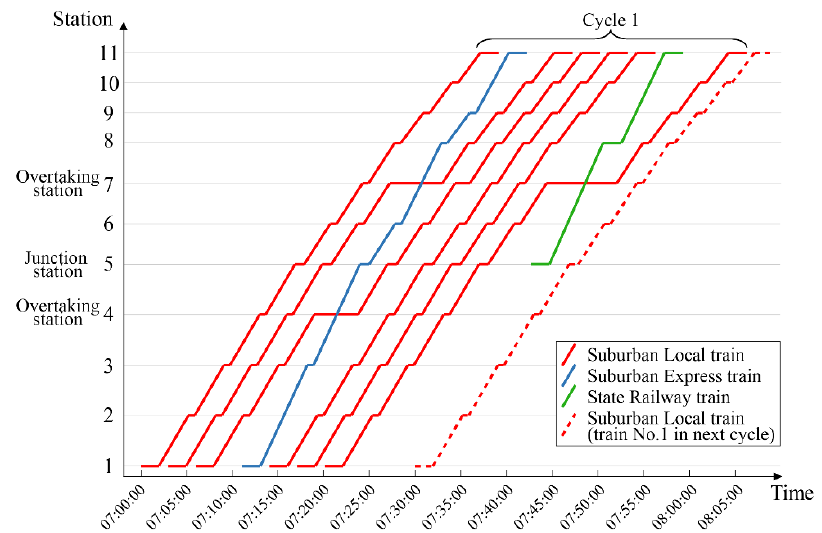
Figure 8. Train timetable under cross ‐ line and skip ‐ stop operation. Table 3. Suburban railway passenger demand in one operation cycle.